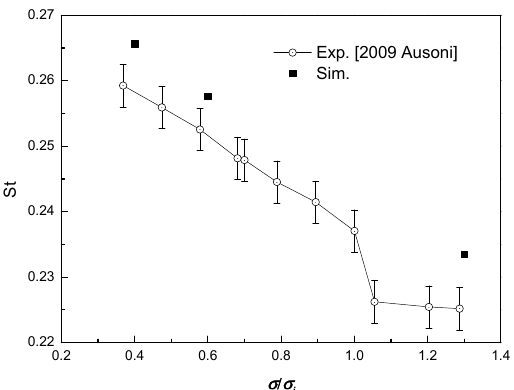
Figure 6. Comparison of Strouhal, St , estimates between the numerical simulations and the experimental measurements at free cavitation conditions and at cavitation conditions.